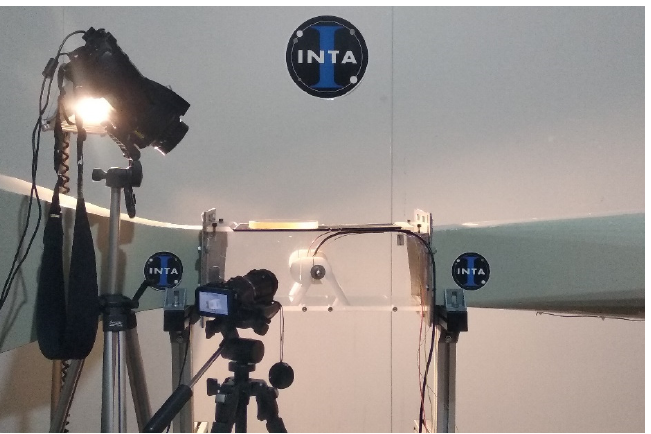
Figure 2. Test section of the icing wind tunnel (IWT) in a cold climate chamber at INTA, Spain. In this study, two icing conditions have been used (see Table 1). Table 1. Summary table of the icing test conditions. Condition 1 generates glaze ice, and condition 2 generates rime ice.